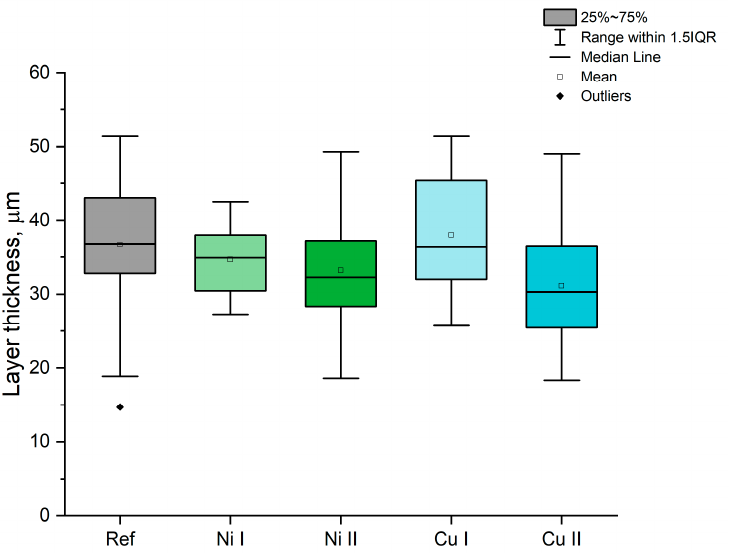
Figure 6. Results of the layer thickness analysis, based on the SEM image of the cross sections of the samples.